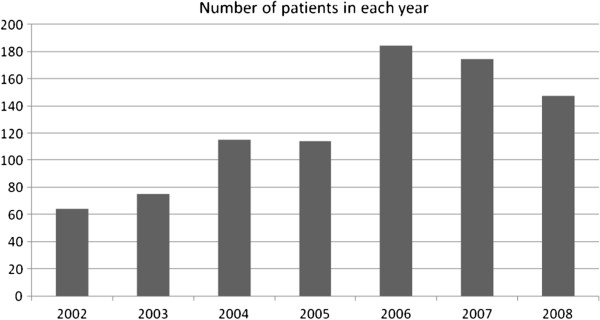
Number of patients in each year. This figure shows that total number of diabetic foot patients who were admitted in the studied hospitals during recent years is significantly more than that during the preceding years.